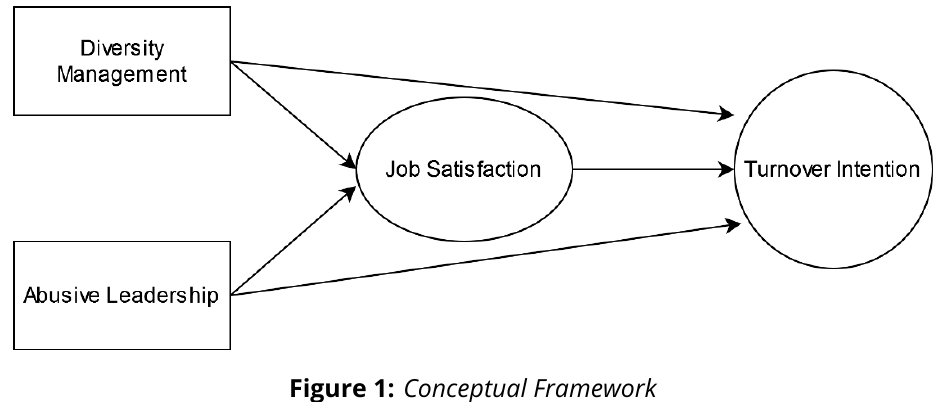
Figure 1: Conceptual